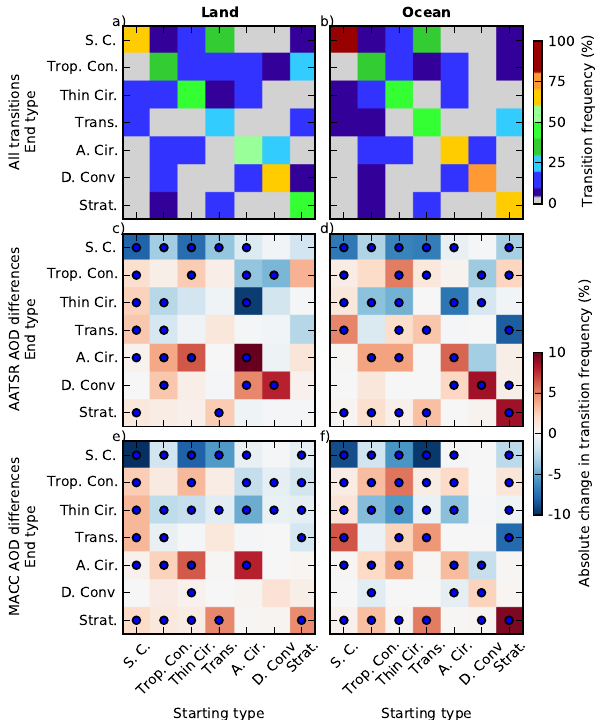
Fig. 9. Regime transition histogram showing the conditional prob- ability of a given transitions between regimes over (a) land and (b) ocean during the 3h afternoon period being observed, given each starting regime. As such, each column sums to 100%. This plot covers regime transitions for the tropical region (20 ◦ N–20 ◦ S). The difference in the histograms between the highest and lowest GlobAerosol AATSR quartile days over (c) land and (d) ocean, and using MACC AOD over (e) land and (f) ocean. Positive values in- dicate an increase in the frequency of the transition with increasing AI. Note the nonlinear colourbar in (a) and (b) . The dots indicate statistical significance.